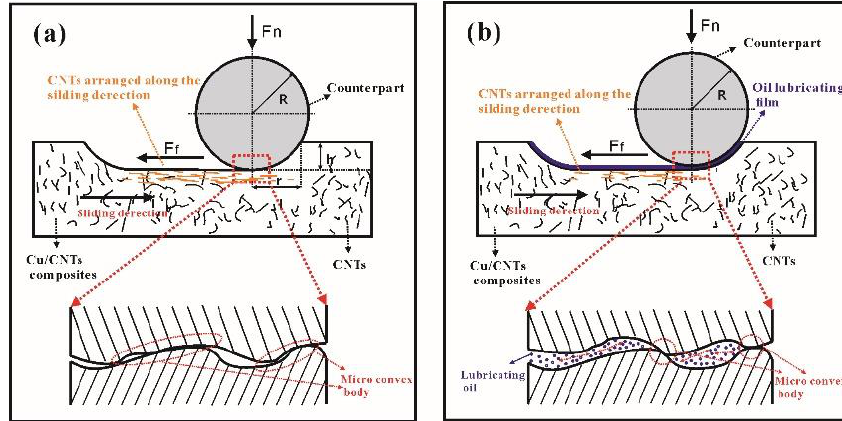
Figure 11. Schematic illustration of wear mechanism: ( a ) dry friction condition and ( b ) boundary lubrication condition.